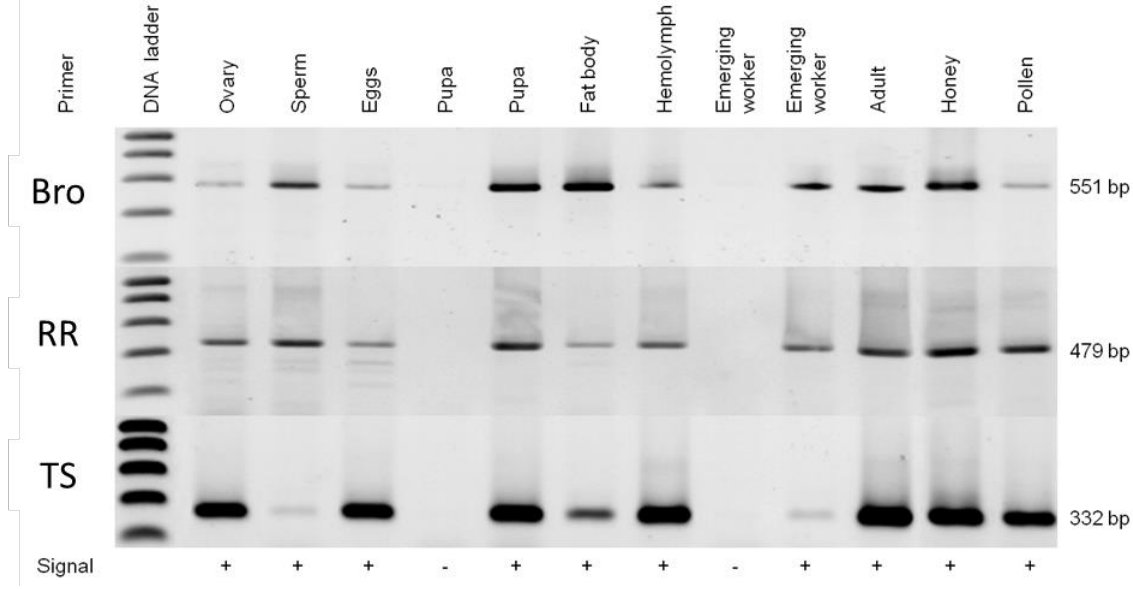
Figure 5. Agarose gel electrophoresis showing AmFV PCR amplicons produced from different individuals (larvae, pupae or adults bees), queen bee tissues, drone sperm or bee products, using three different primer pairs (the thymidylate synthase (TS) primers were described by Cornman et al. (2010) [20]).